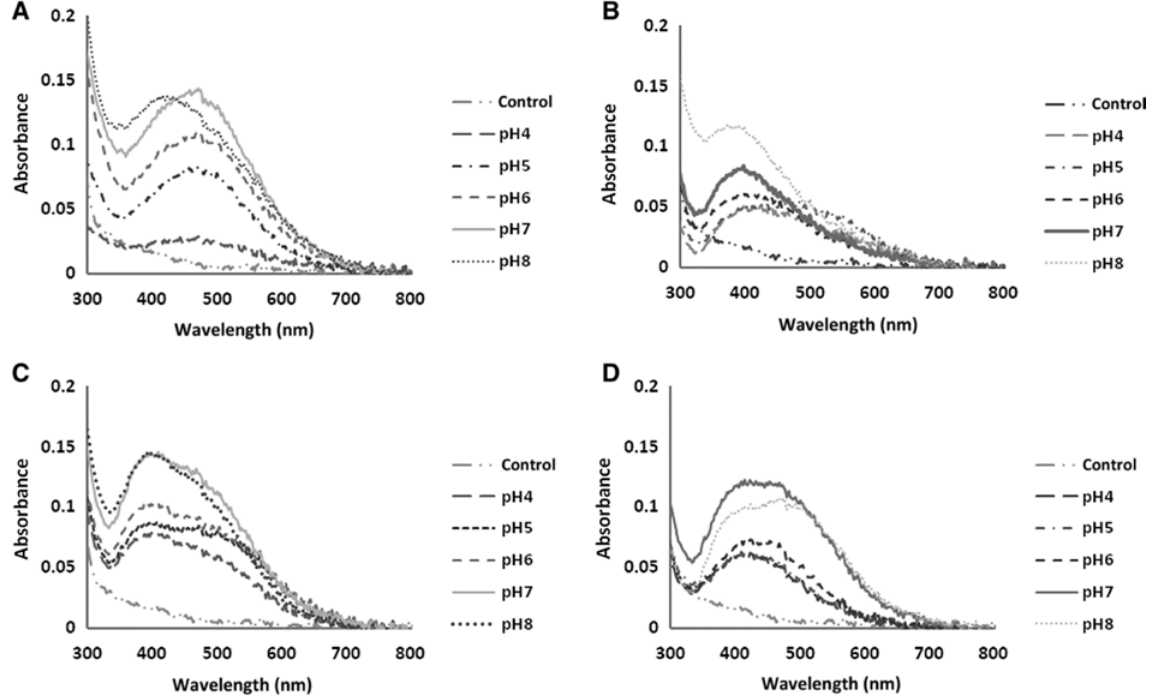
Figure 3: The absorption spectra of AgNPs biosynthesized under various conditions of pH. N. valliformis OT1 strain (A); S. palmae OF1 strain (B); S. palmae OF2 strain (C); S. alkaliphilus IF19 strain (D).